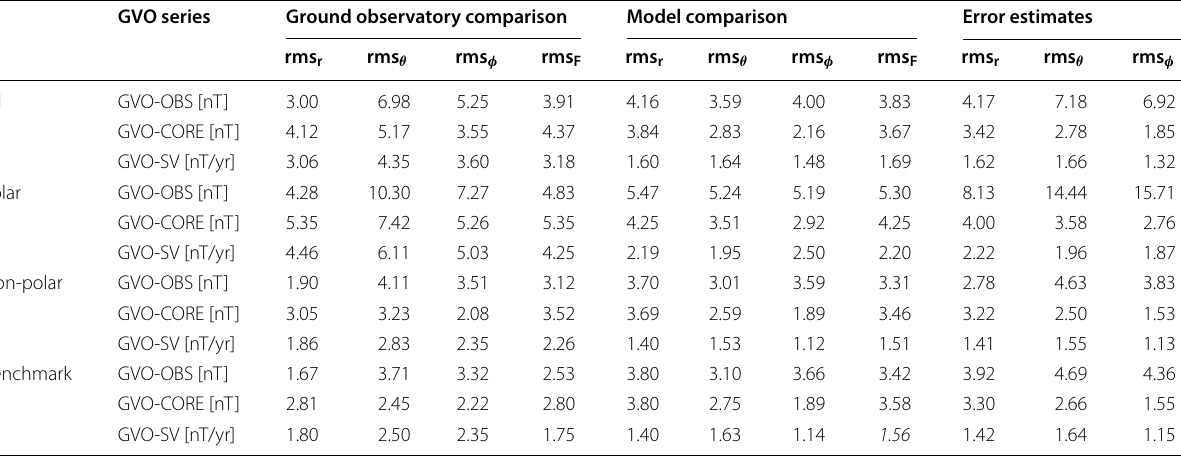
Table 3 Summary of validation tests for the 1-monthly GVO products